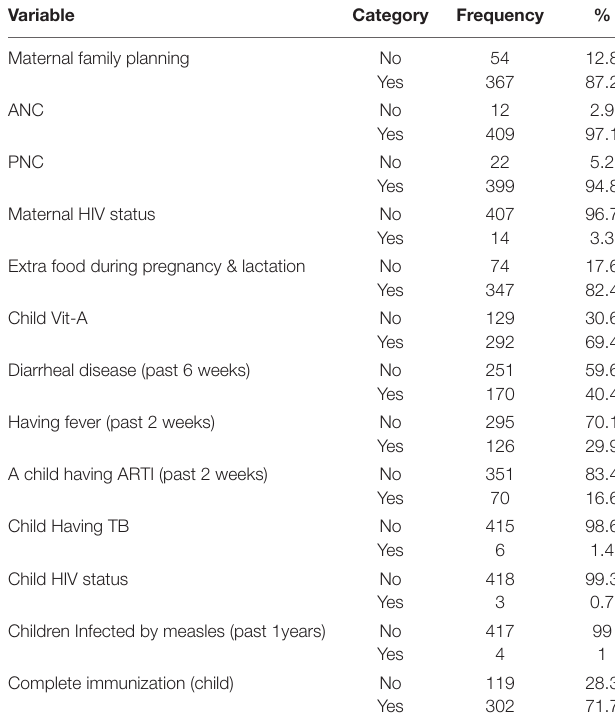
TABLE 4 | Maternal and child health characteristics, Dessie Town, South Wollo Zone, Northeastern Ethiopia,